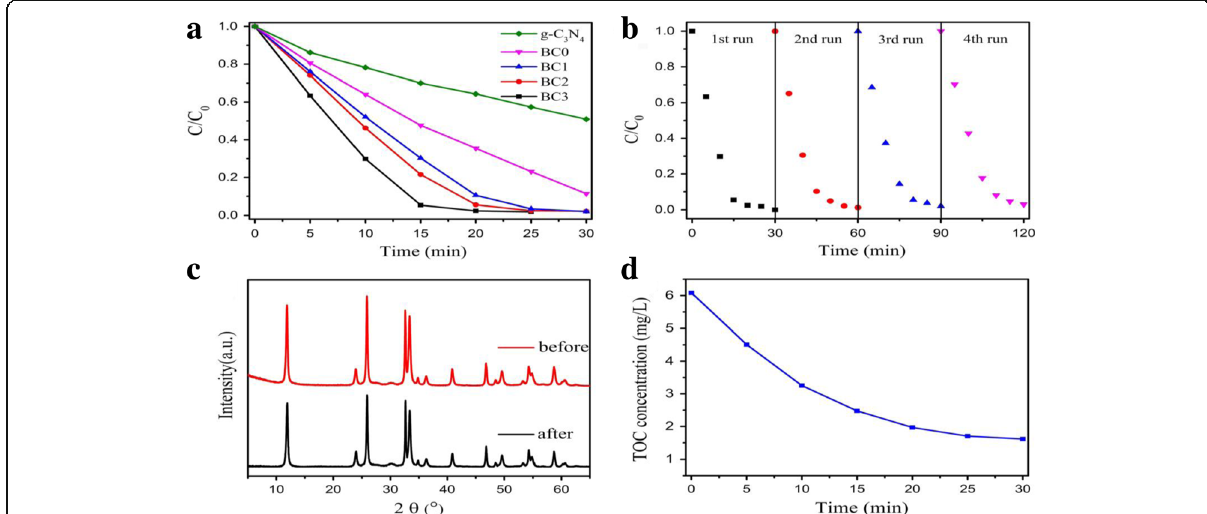
Fig. 6 Schematic diagram of Preparation and Enhanced Visible-light Photocatalytic by the decrease of RhB by different photocatalysts as a function of visible light irradiation time (photocatalysts loading, 0.5 g/L; initial RhB concentration, about 10 mg/L, without pH modulation). The photocatalysts used were pure g-C3N4 and a series of g-C3N4/ BiOCl hybrids, b cyclic degradation of RhB over BC3, c XRD patterns of BC3